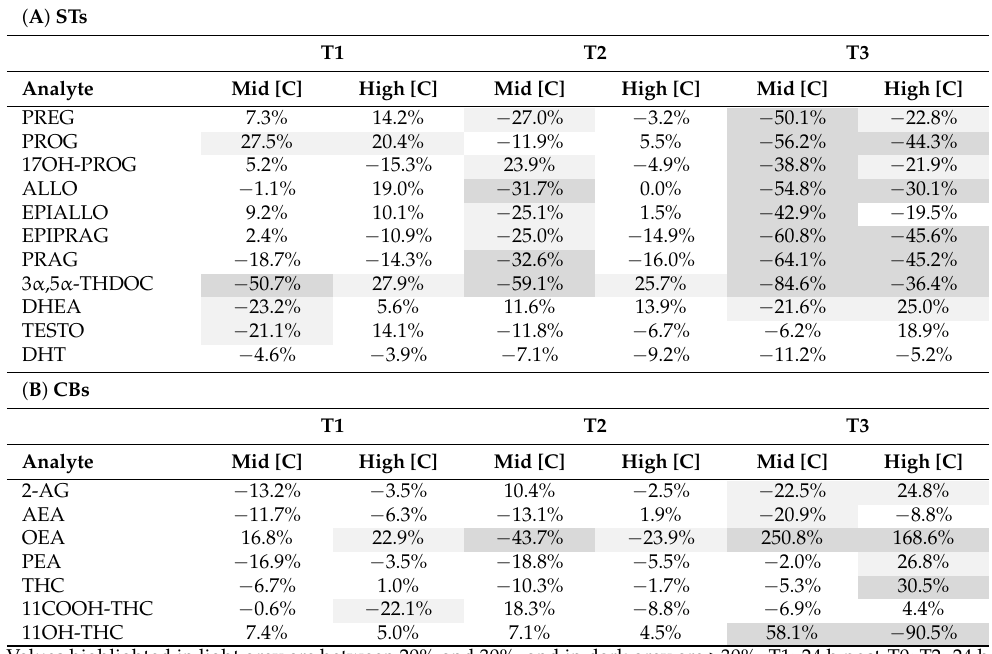
Table 10. Freeze and thaw stability for steroids (STs) ( A ) and cannabinoids (CBs) ( B ) expressed as mean% of difference (n = 4) (compared to T0) at mid and high concentration levels